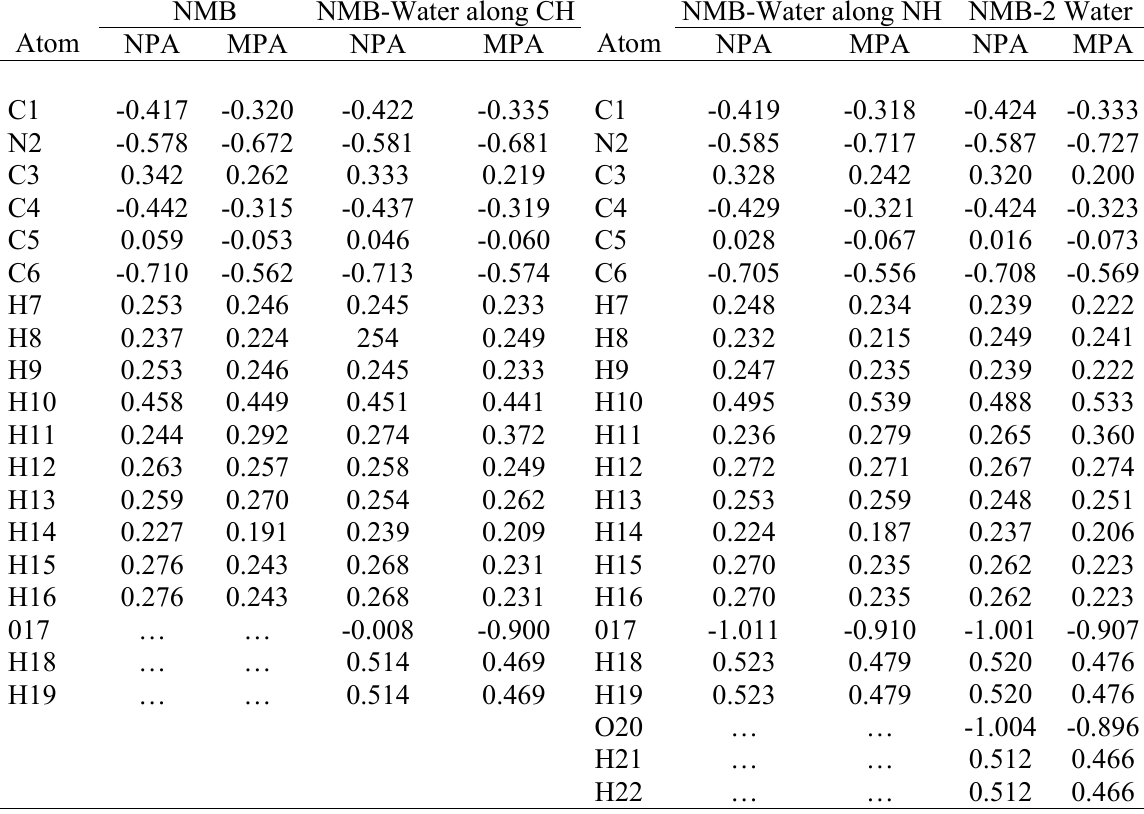
Table 4. Atomic charges of NMB and NMB-water complexes calculated at NPA and MPA